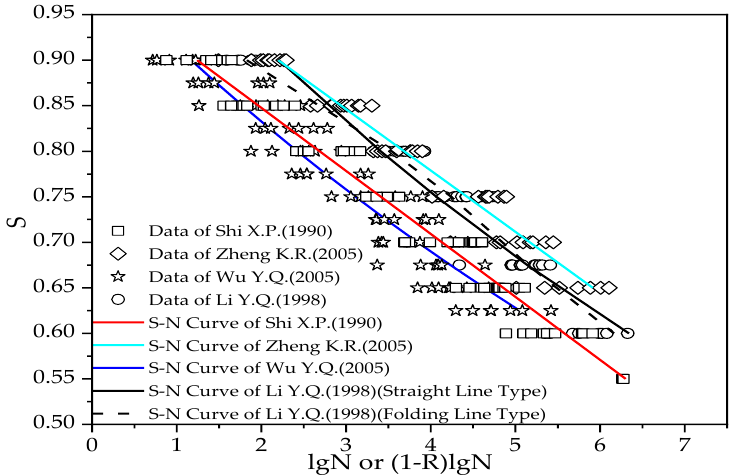
Figure 9. Test data and S-N curve from literature.